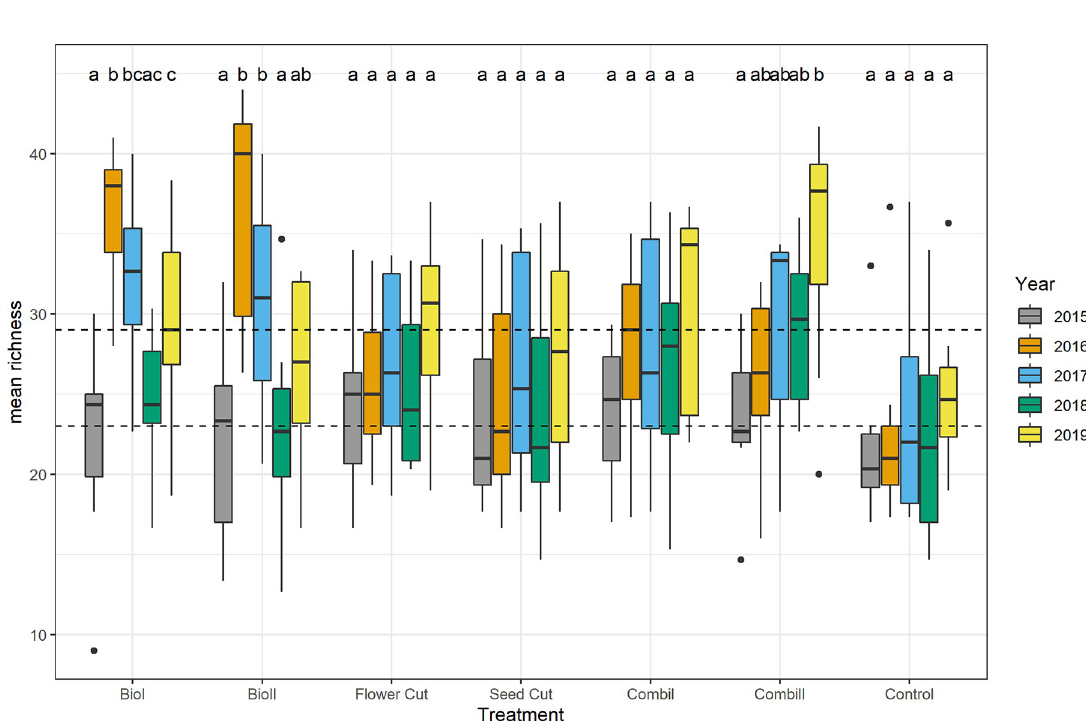
Fig 7. Species richness according to year and treatment. For explanation of the boxplot, refer to Fig 3. Different letters indicate significant differences (P � 0.05; Tukey HSD) between years within one treatment. Dashed lines indicate mean species richness in 2015 (lower line) and 2019 (upper